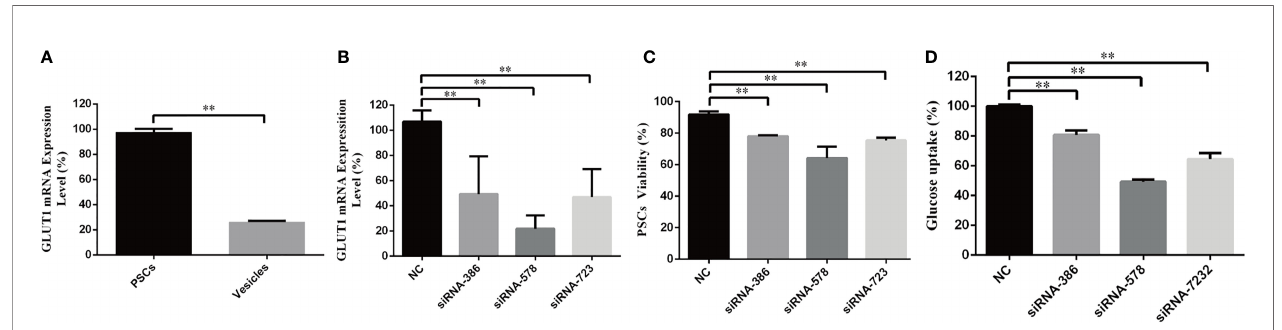
FIGURE 2 | EgGLUT1-ss Knockdown reduces the viability and glucose uptake of PSCs. (A) EgGLUT1-ss mRNA expression in PSCs and vesicles. (B) EgGLUT1-ss mRNA expression at 48 h after siRNA-386, siRNA-578 and siRNA-723 interference. (C) PSCs viability at 48 h after siRNA-386, siRNA-578 and siRNA-723 interference. (D) Glucose uptake of PSCs at 48 h after siRNA-386, siRNA-578 and siRNA-723 interference. ** Show a statistically signi fi cant difference between the siRNA interference group and the NC group at the indicated times (** P < 0.01) (chi-square test and one-way ANOVA). Data are the mean ± S.D. of three independent experiments. NC, negative control group (transfection by independent interference sequence).